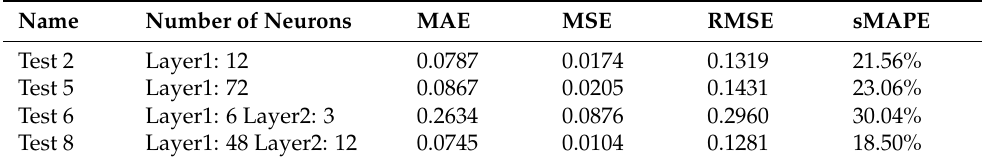
Table 5. RMSprop algorithm final test results.